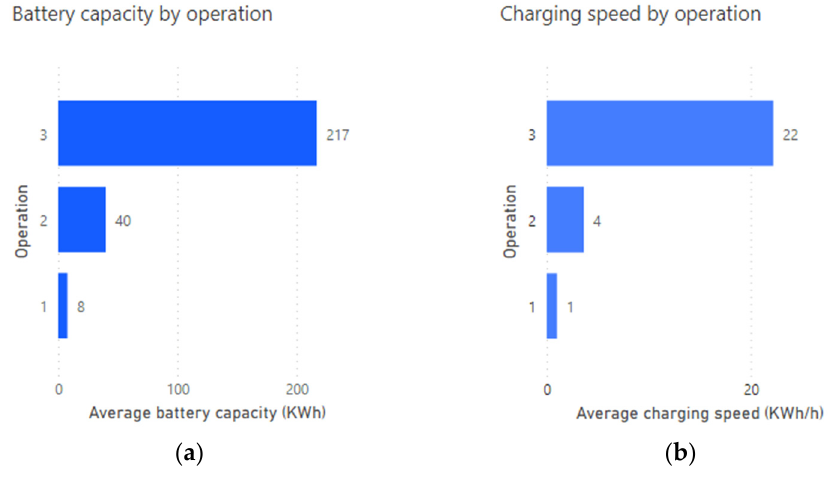
Figure 9. ( a ) Battery capacity by operation; ( b ) charging speed by operation.